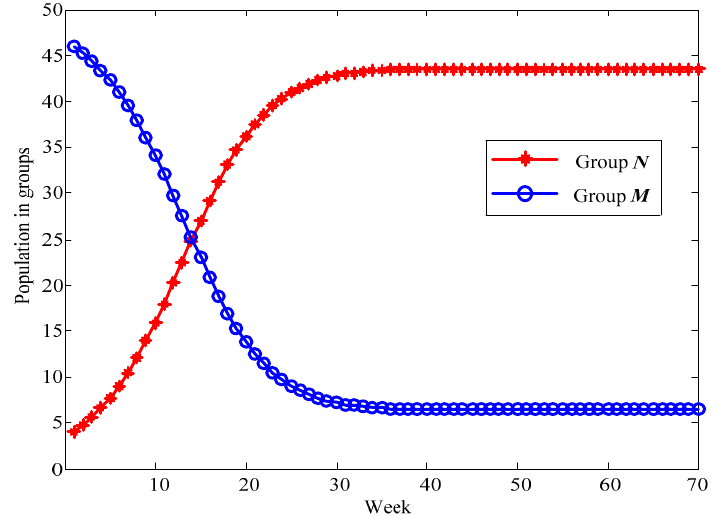
Figure 3. Convergence process of population in groups N and M.